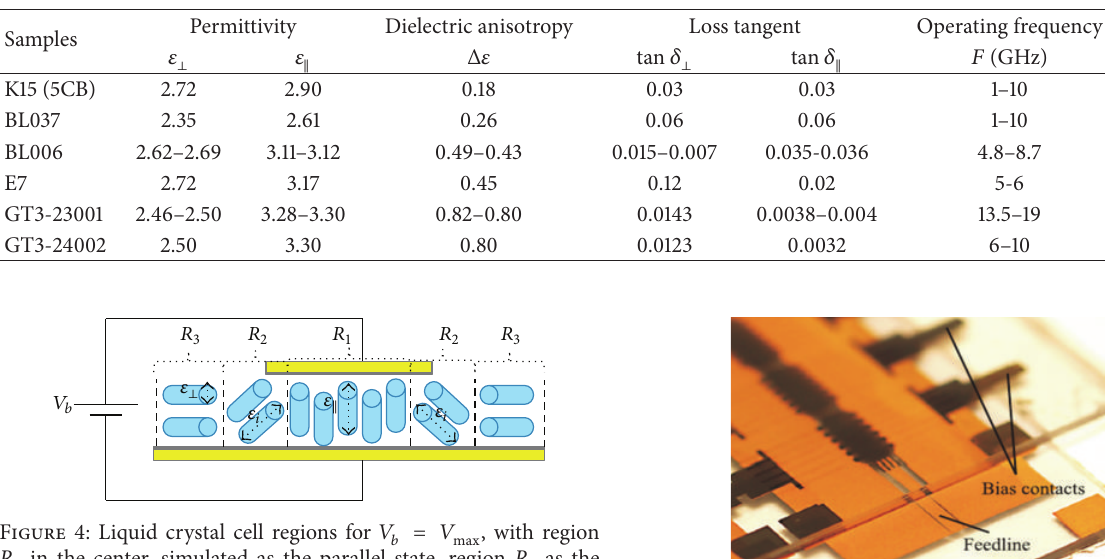
𝑅 2 as the Figure 5: Photograph of the realized tunable filter containing liquid crystal mixture